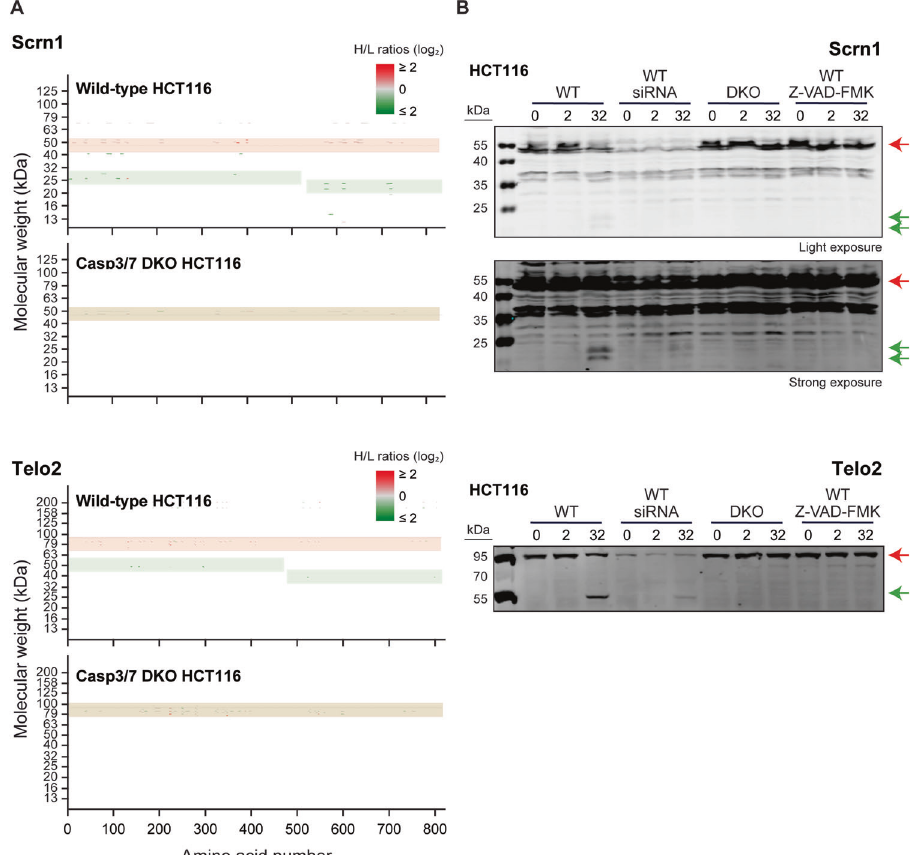
Fig. 4 Validation of the CASP3/ CASP7-dependent cleavage of Scrn1 and Telo2 by Western blotting. A Visualization using the Popviz interface of the cleavage pattern of Scrn1 and Telo2 in HCT116 cells. B Wild-type and CASP3/CASP7 DKO HCT116 cells were incubated with the indicated cisplatin concentrations for 48 h and the presence of the indicated proteins was then evaluated by western blotting. The speci fi city of the antibodies used during the western blotting was assessed upon siRNA-mediated silencing of SCRN1 or Telo2 in cells (WT/ siRNA lanes) prior exposure to cisplatin (see the methods). As an independent approach, caspases were inactivated by incubating the cells two hours prior cisplatin exposure with 50 µM of the pan caspase inhibitor Z-VAD-FMK, keeping the inhibitor in the culture medium when cisplatin was added. Red arrows point towards the full-length protein and green arrows to proteolytic